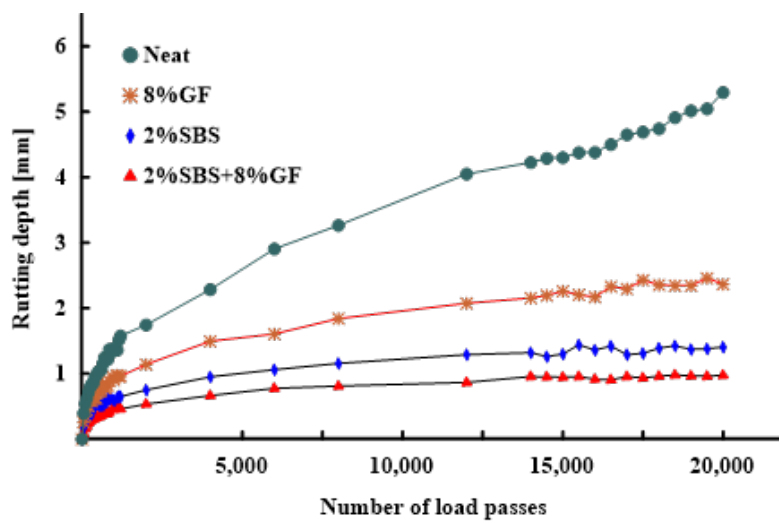
Figure 12. Additives effects on the rut depth of asphalt